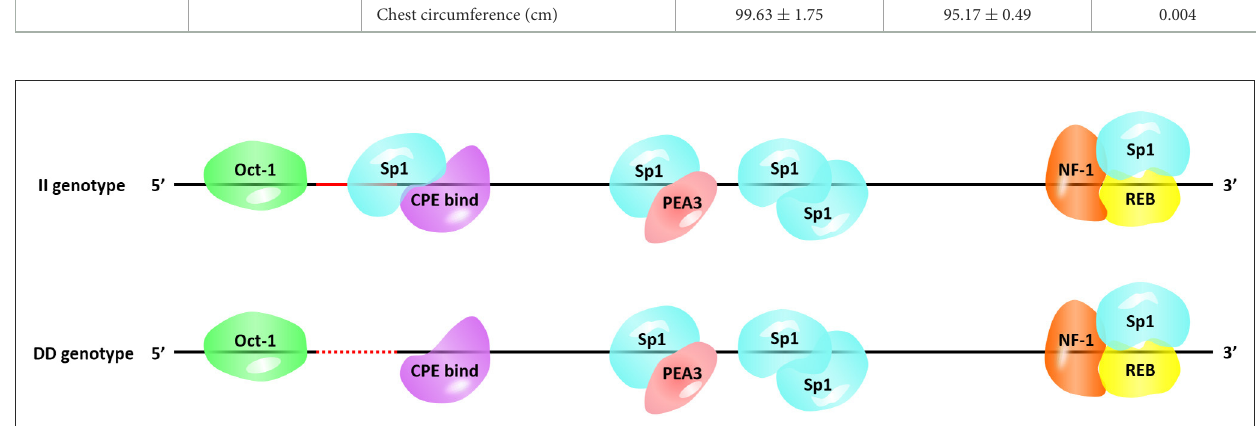
FIGURE4 Transcription factor binding sites on the 9-bp InDel locus.